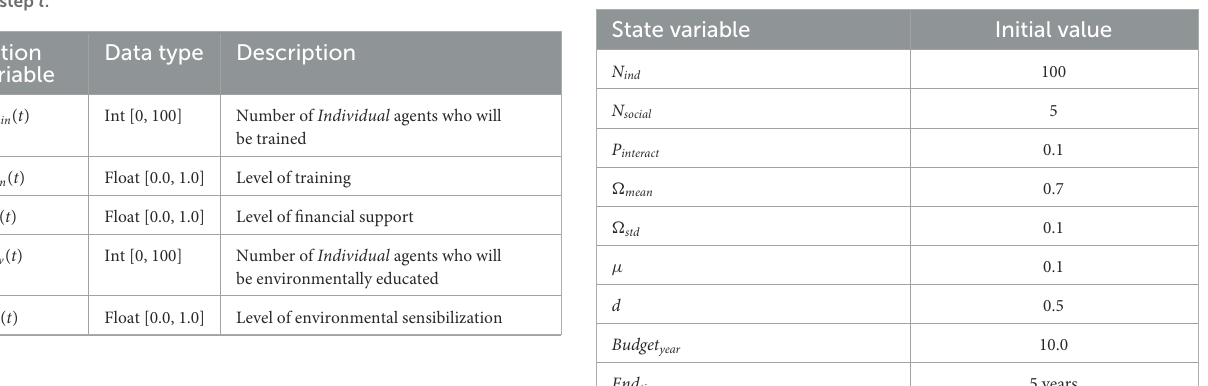
TABLE 4 Parameter values used for the